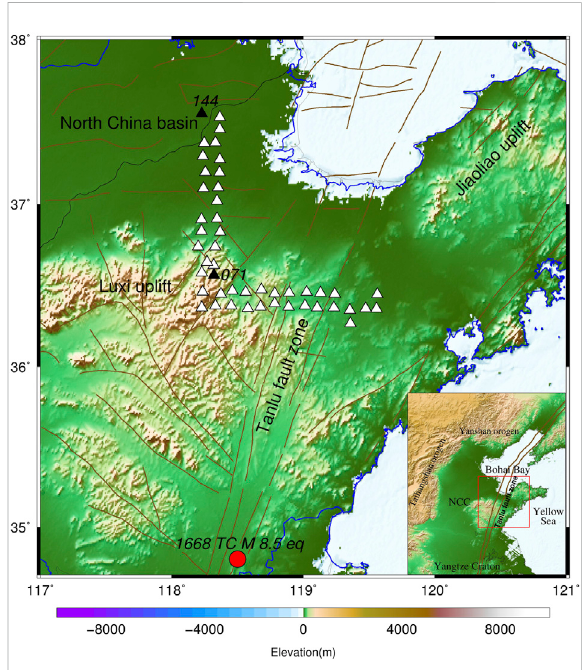
FIGURE 1 Tectonic map of the Luxi uplift segment of the Tanlu fault zone and the distribution of seismic stations used in this study. Triangles denote 47 NCISP portable seismic stations (www.iris. edu), of which two black triangles denote Stations 071 and 144 used in Figure 3. The red circle denotes the epicenter of the 1668 Tancheng (TC) M 8.5 earthquake. The inset shows the locationofthestudyregion.NCC,theNorthChinaCraton.Thered lines denote major active faults (Deng et al.,